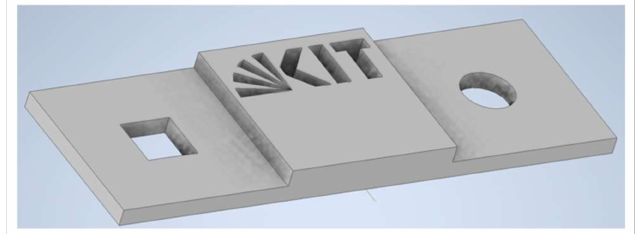
Figure 16. “KIT logo” sample for the validation of vertical-printed